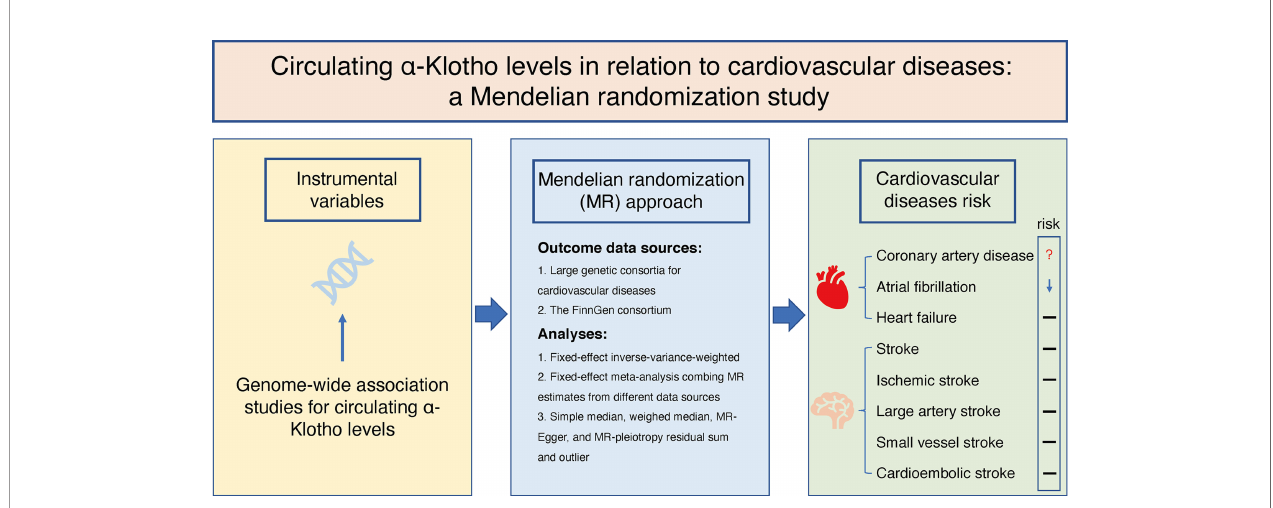
FIGURE 1 | Schematic representation of this two-sample Mendelian randomization